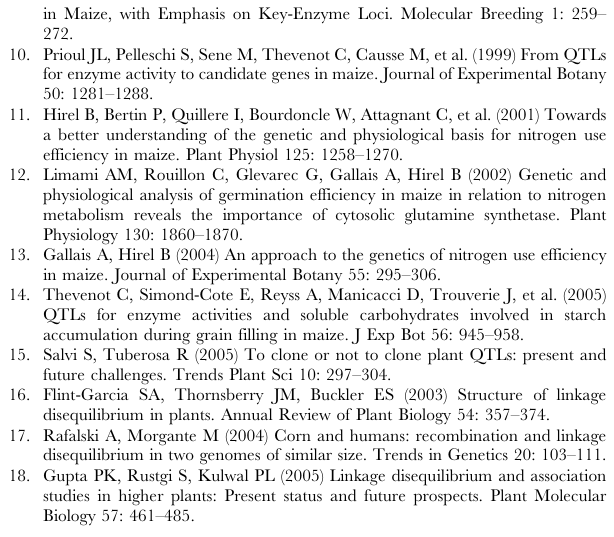
Table S1 Activities of nine CCM enzymes for eight different maize inbred lines in five replications.